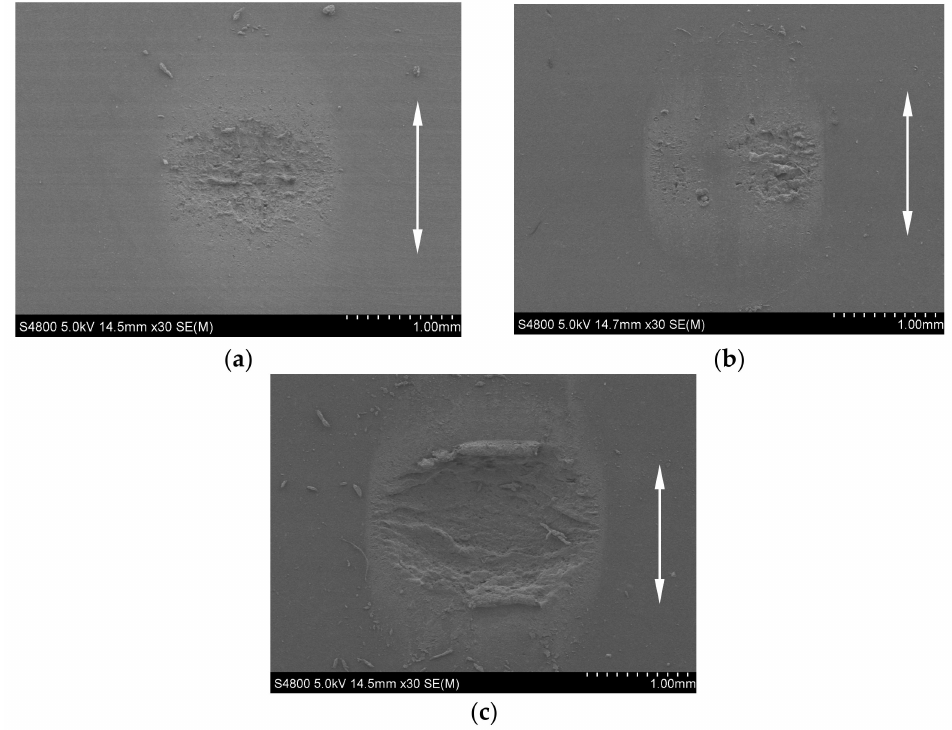
Figure 9. The SEM morphology of three rubbers under F n = 5 N, d = ± 0.45 mm, f = 5 Hz, H = 70 Ha, and N = 10 5 cycles: ( a ) FPM; ( b ) NBR; and ( c )